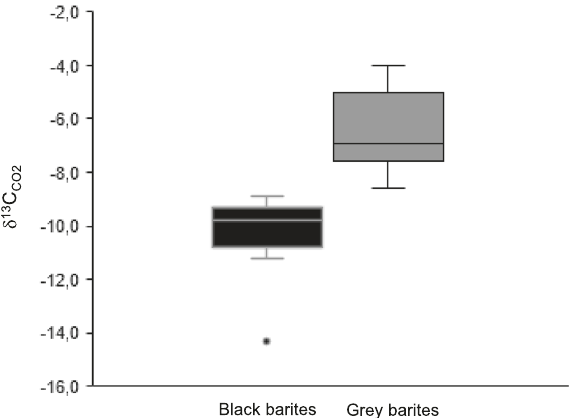
Fig. 6 Distribution of stable carbon isotope signatures of CO 2 from black and grey barite fl uid inclusions. Reproducibility of the stable isotope measurements is 0.3 ‰ . A total of 11 black barite samples and 11 grey barite samples was analysed. The relatively low δ 13 C values in the black barites possibly re fl ect the addition of a biomass-derived carbon component to the fl